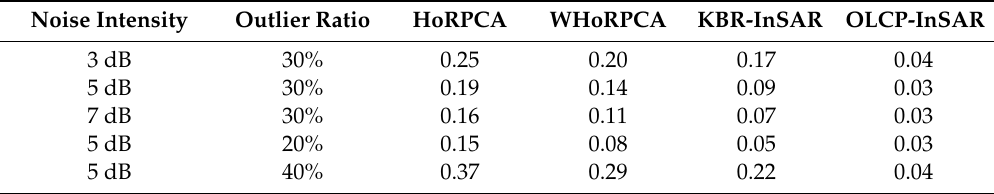
Table 1. The mean square error (MSE) of filtered tensors with di ff erent noise conditions.